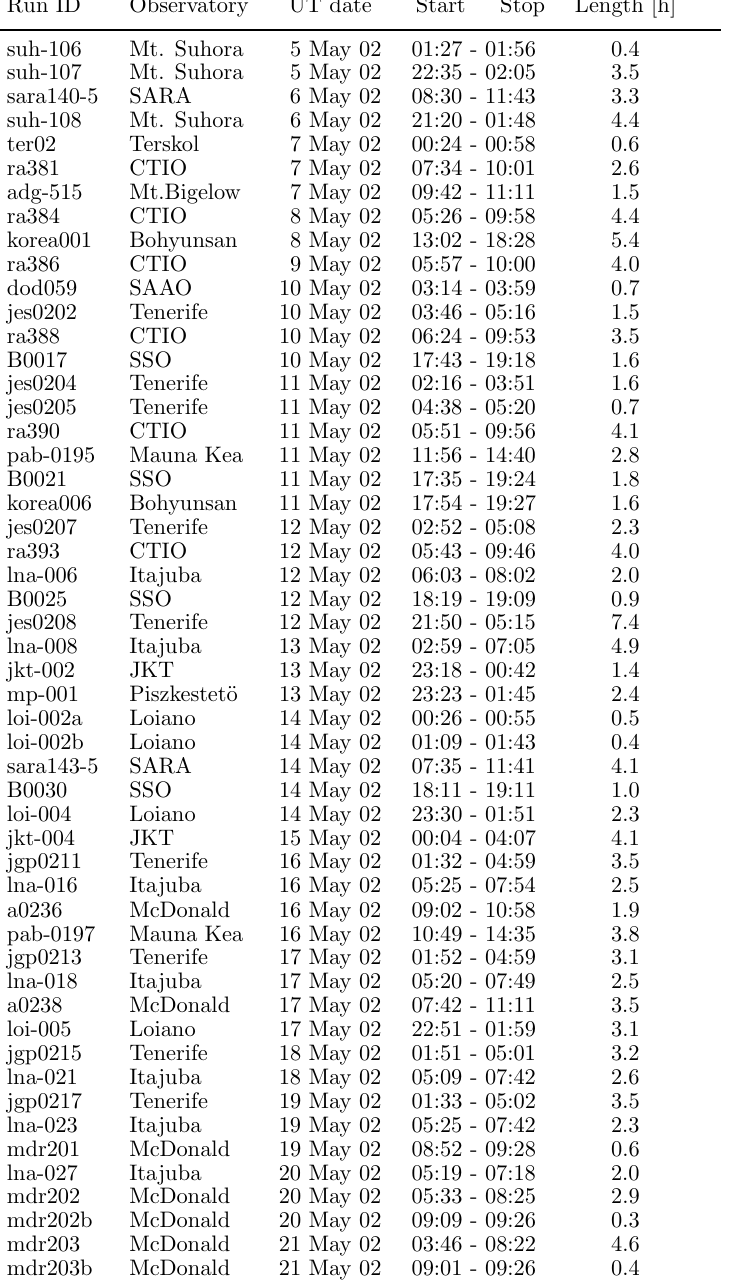
Table 3. WET XCov22 data sets on PG